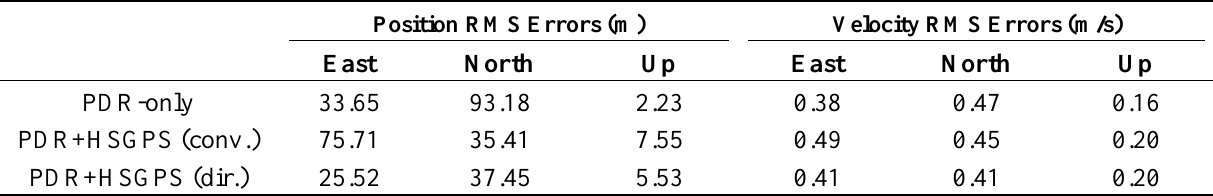
Table 3. Position and velocity RMS errors.